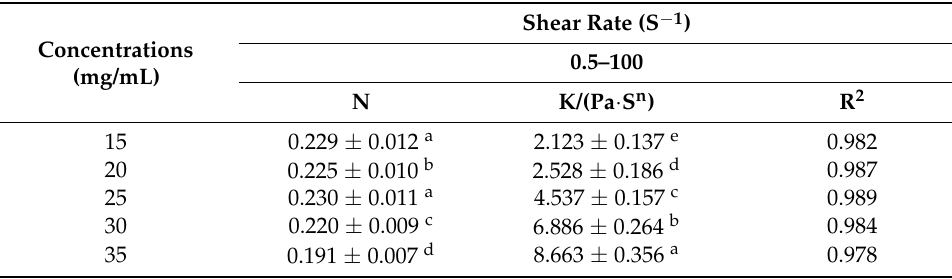
Table 1. Power law equations and coefficients of the Pickering emulsion prepared at different concentrations of SPI and maltose.